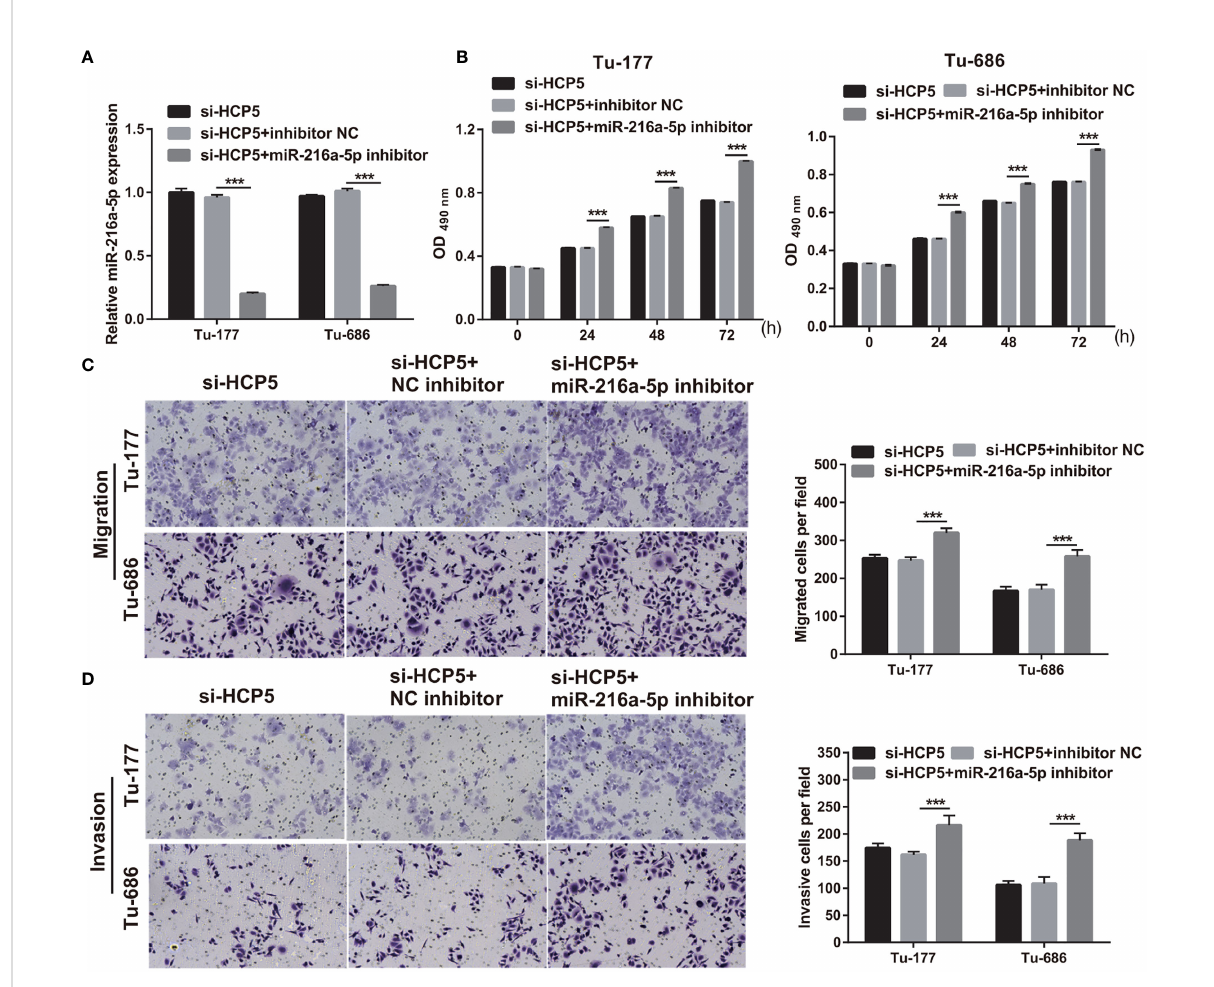
FIGURE 5 miR-216a-5p-silenced can attenuate si-HCP5 effect in LSCC cells. (A) miR-216a-5p expression was quanti fi ed by qRT-PCR in Tu-177 and Tu- 686 cells after cotransfected si-HCP5 and miR-216a-5p inhibitor. (B) The effect of cotransfected si-HCP5 and miR-216a-5p inhibitor on proliferation in Tu-177 and Tu-686 were determined by MTS assay. (C, D) The effect of cotransfected si-HCP5 and miR-216a-5p inhibitor on the migration and invasion of Tu-177 and Tu-686 were assessed by Transwell assay; the presented pictures were captured with 100× magni fi cation. n =3, ***p